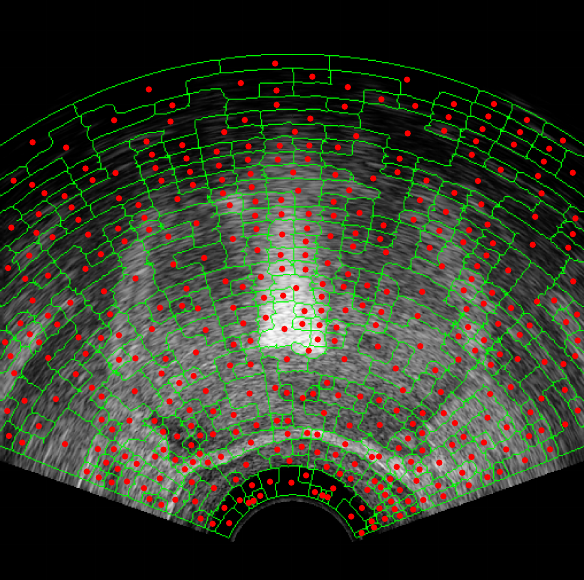
Figure 9. Output of superpixel algorithm in TRUS image frame { U } with region borders shown in green and region centroids indicated with red